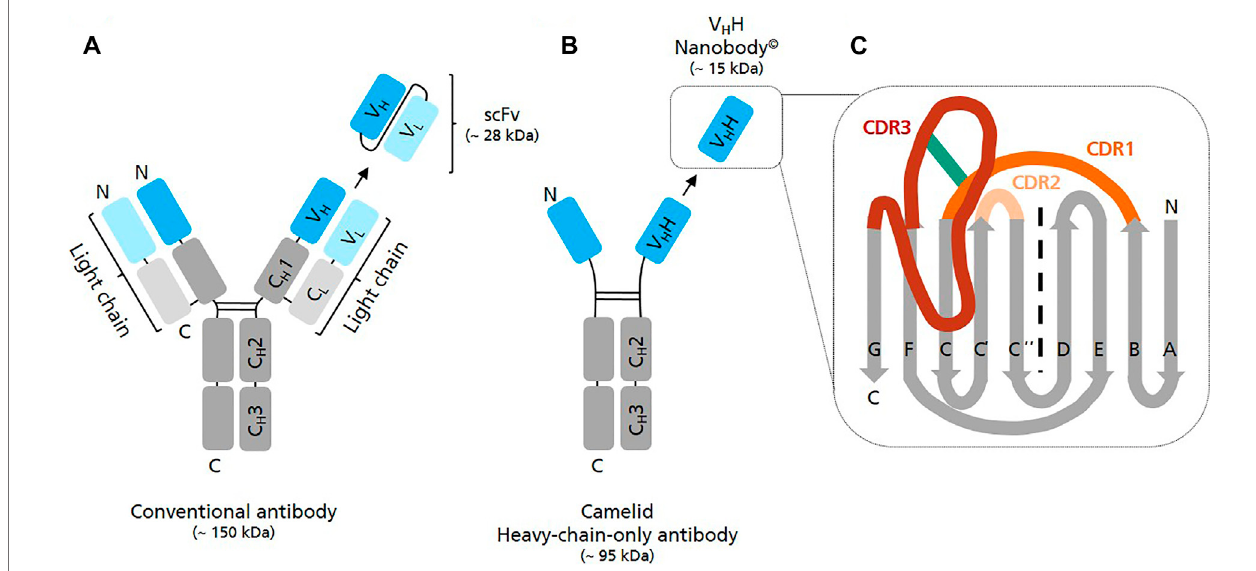
FIGURE1| Graphicalrepresentationofdifferentantibodystructuresandrecombinantlyexpressibleformats. (A) AconventionalfulllengthIgGantibodyconsistsof two identical light (variable — V L and constant — C L domain) and two identical heavy polypeptide chains (variable V H and constant — C H 1/2/3 domains) which assemble into a heterotetramer. Single chain variable fragments (scFv) are recombinant binders consisting of the variable domain of antibody heavy chain (V H ) and antibody light chain(V L ) fused bya fl exible peptide linker. (B) Acamelidheavy-chain-only antibody (HCAb) consists oftwoidentical heavy polypeptide chains (variable — V H Hand constant C H 2/3 domains) forming a homodimer. The antigen binding region of HCAbs is called V H H domain or Nanobody. (C) Schematic view of the V H H domain consisting of 2 ß-sheets, one with 4 and one with 5 ß-strands. Scaffold ß strands are depicted in grey (A, B, E, D, C ″ , C ′ , C, F, G), antigen-binding loops in dark orange (CDR1), light orange (CDR2) and in red (CDR3). The frequently observed interloop disul fi de bond betwenn CDR1 and CDR3 is depicted in